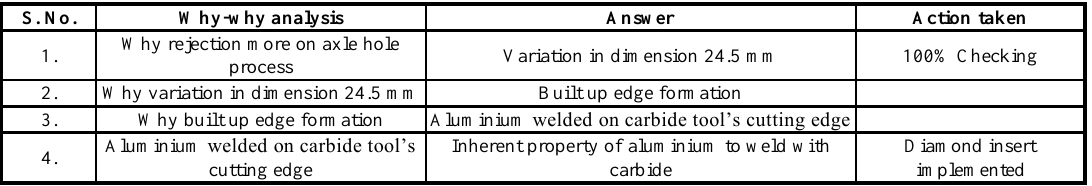
Table 3. Why-why analysis for variation in dim.